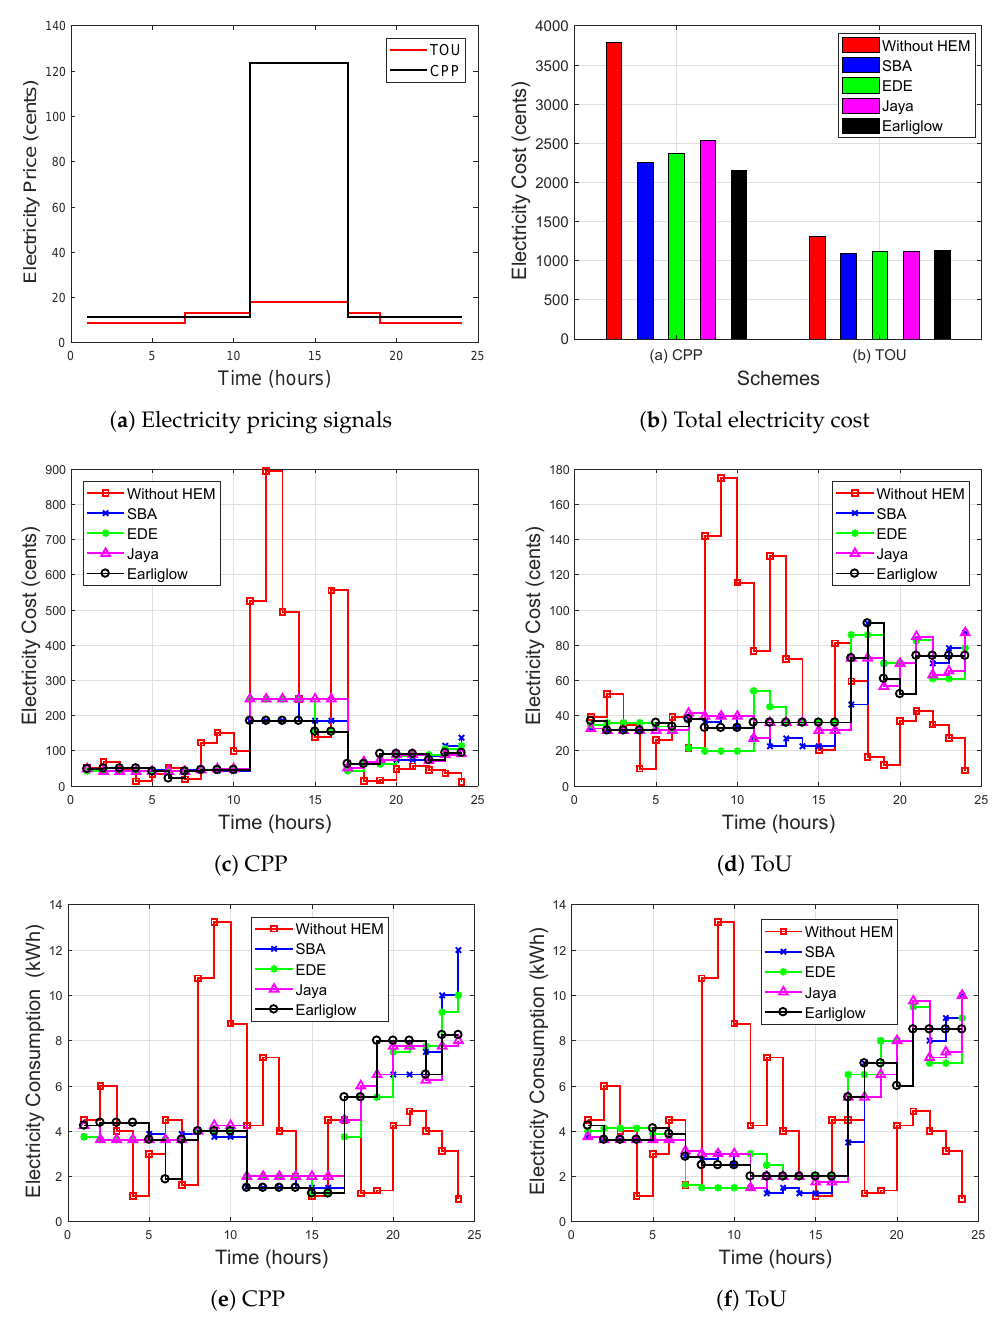
Figure 5. ( a ) electricity pricing signals; ( b ) total electricity cost; ( c ) hourly electricity cost using critical peak price (CPP); ( d ) hourly electricity cost using time-of-use (ToU); ( e ) hourly electricity consumption without renewable energy sources (RES) using CPP; ( f ) hourly electricity consumption without RES using